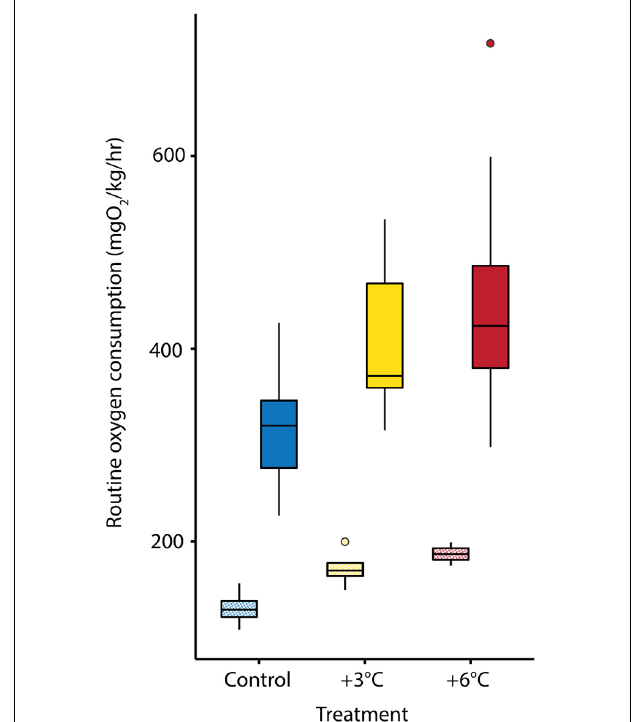
FIGURE 2 | Routine metabolic rate (mgO 2 /kg/h) of juvenile and adult pinfish. Data for the adult pinfish are shown in hashed boxplots, and data for the juveniles are shown in solid boxplots. Boxes are colored by experimental treatment, where blue corresponds to the control treatment, yellow corresponds to the +3 ◦ C treatment, and red corresponds to the +6 ◦ C